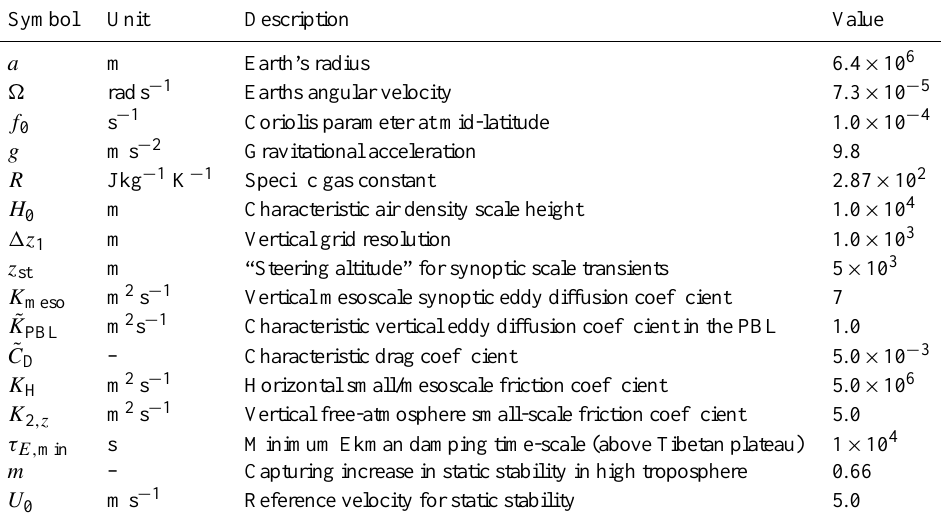
Table 2. Description of used